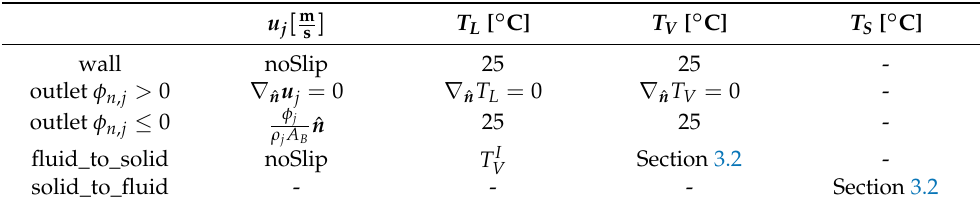
Table 6. Horizontal plate boundary conditions. φ n , j stands for mass flow rate through a boundary cell